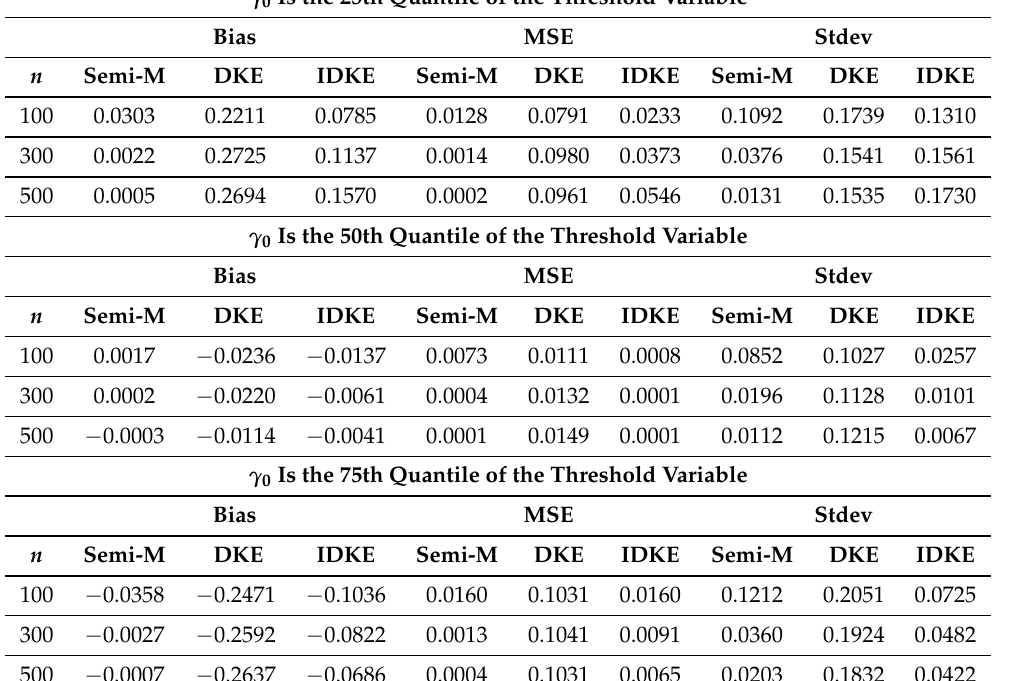
Table 3. Simulation results of nonparametric threshold estimators, DGP